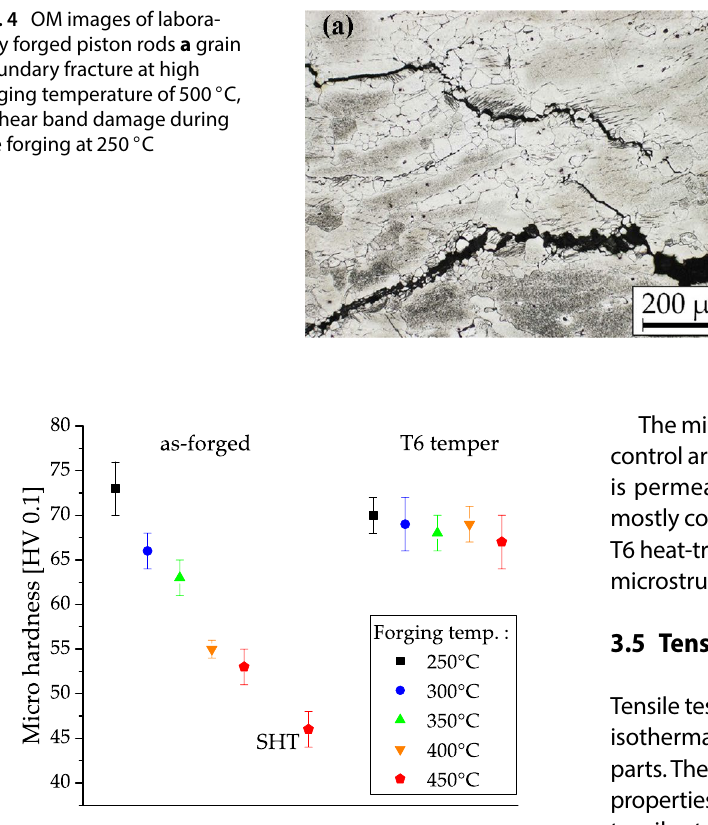
Fig. 5 Results from microhardness testing (HV0.1) of laboratory forged piston rods, showing as-forged, solution heat treated and peak aged material, including standard